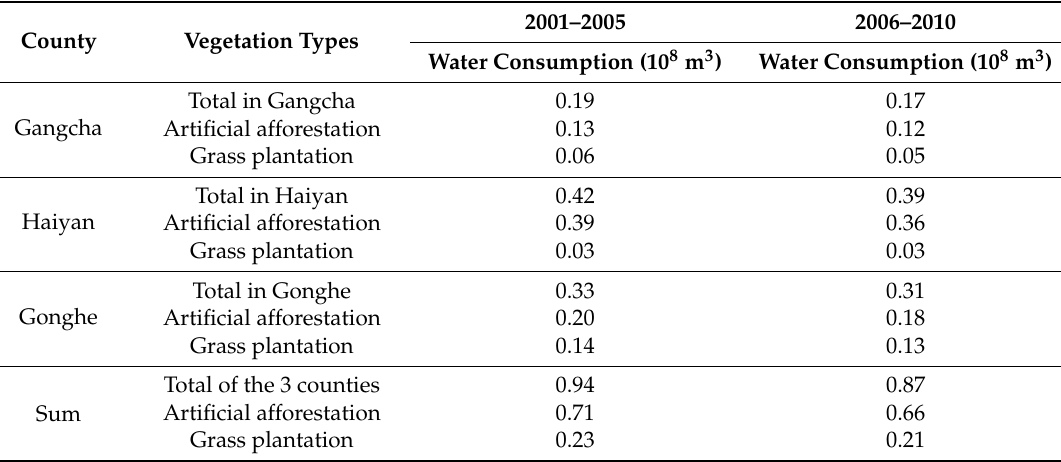
Table 5. Artificial afforestation and grass plantation water consumption in Qinghai Lake catchment from 2001 to 2010.